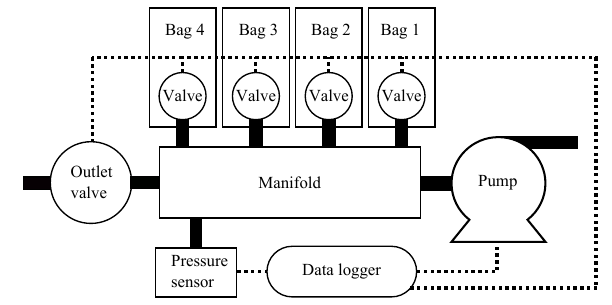
Figure 1. A schematic diagram of the sampler. Four bags are con- nected to a custom-made manifold. A small servomotor operates the screw cap combo valve. The outlet valve is the same as that of the bags, but is normally open when the sampler is idle during flight, allowing air pressure to equilibrate with outside air. Pressure inside the manifold is monitored by a pressure sensor. A data log- ger is used to control all of the electronics. Electric connections are shown with dashed